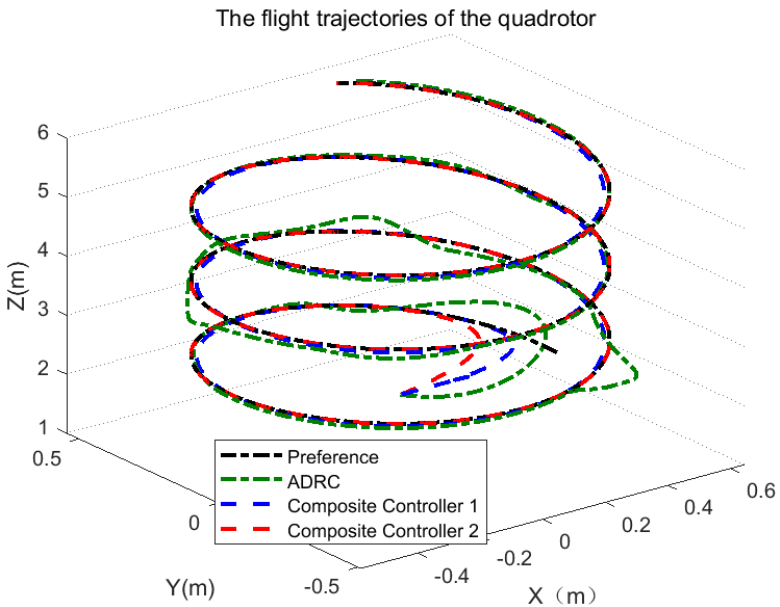
Figure 7. The flight trajectories of the QUAV under actuator constant fault and disturbance condition.